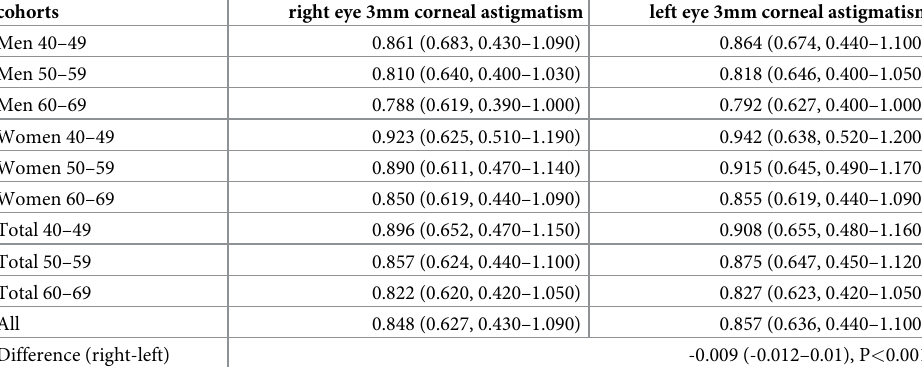
Table 2. Mean, standard deviation, 25th and 75th percentile of right and left corneal astigmatism by age and gen- der of the 83,751 study participants in the UK Biobank. Corneal astigmatism decreases slightly with age and is slightly higher in females than in males. Left corneal astigmatism tends to be very slightly but significantly higher than right corneal astigmatism (P < 0.001). P values derived from a t-test between right and left eye corneal astigmatism across all